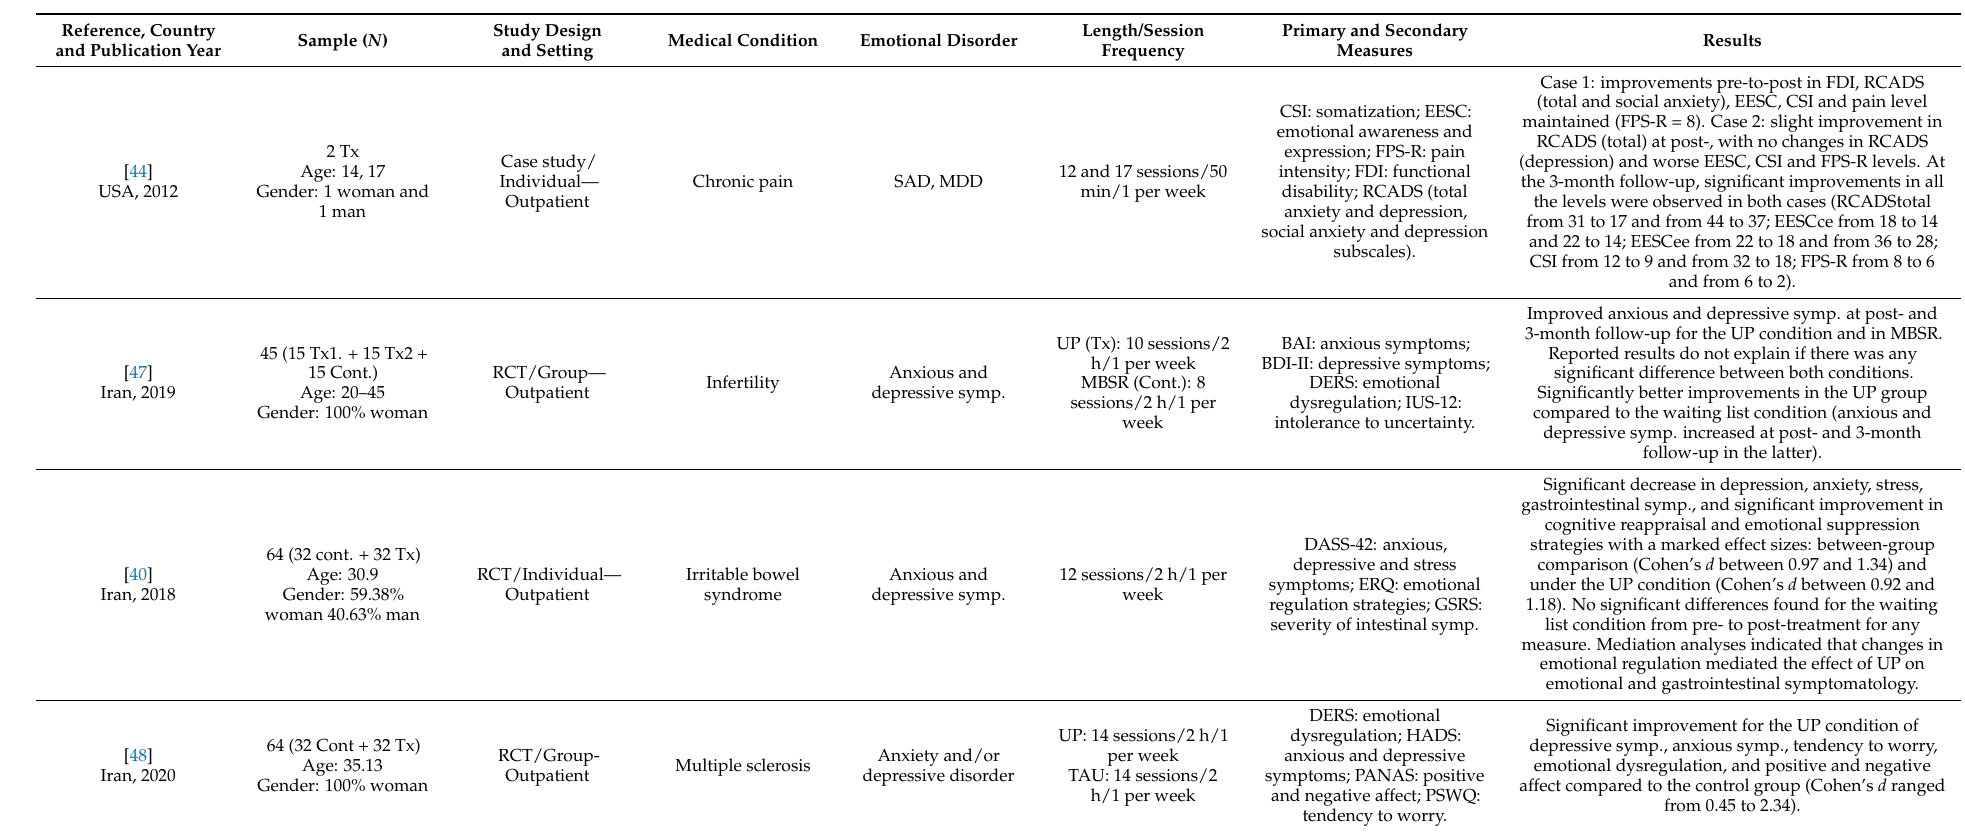
Table 1. Characteristics of the included research